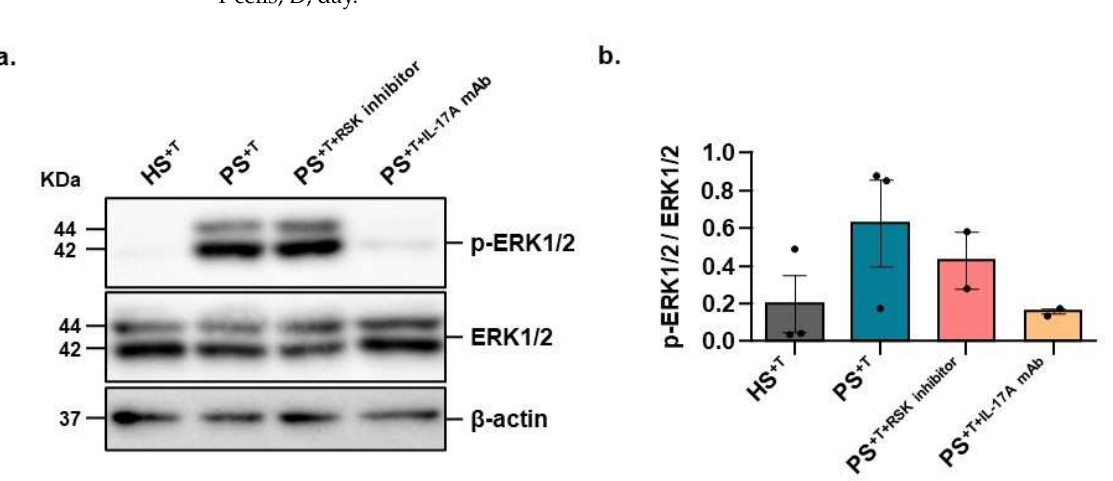
Figure 4. Contribution of ERK1/2 signaling pathway in psoriasis. ( a ) Total protein (20 µg) from the epidermal fraction of HS +T , PS +T , PS +T+RSK inhibitor and PS +T+IL-17A mAb was loaded on a 10% reducing SDS- PAGE gel. The expression of p-ERK1/2 and total ERK1/2 (ERK1/2) was monitored by Western blot analysis. β-actin is shown as a loading control. ( b ) Densitometric analysis of the immunoblots (three donors (HS +T and PS +T ) and two donors (PS +T+RSK inhibitor and PS +T+IL-17A mAb ), two skin substitutes per donor). HS +T , healthy skin substitutes with T cells; PS +T , psoriatic skin substitutes with T cells; PS +T+RSK inhibitor , psoriatic skin substitutes with T cells treated with a RSK inhibitor; PS +T+IL-17A mAb , pso- riatic skin substitutes with T cells treated with an IL-17A-neutralizing antibody. 3.5. DNA-Binding Properties of Sp1 and NF-κB in Healthy and Psoriatic Keratinocytes Stimulated by T Cells Transcription factors mediate many cellular processes by initiating and regulating gene transcription. They can act as both activators and/or repressors of transcription. In order to investigate in more detail the differences in ERK1/2 phosphorylation between healthy and psoriatic conditions, we evaluated the DNA-binding properties of two tran- scription factors that are downstream nuclear targets of ERK1/2, namely, Sp1 and NF-κB, in nuclear extracts prepared from monolayers of either healthy or psoriatic keratinocytes stimulated with T cells. EMSA analyses clearly demonstrated that the DNA-binding prop- erties of these two transcription factors are strongly increased in psoriatic keratinocytes compared with healthy ones (Figure 5a,b). The specificity of the complex formation was validated by competition experiments. Indeed, the formation of both the Sp1 and NF-kB complexes was prevented only by unlabeled competitor oligonucleotides bearing their respective high-affinity DNA binding sites (Figure 5c,d). Moreover, the addition of anti- bodies directed against either Sp1 or NF-κB significantly reduced the formation of these complexes in EMSA and also produced new, slow-migrating supershifted complexes (SCC), confirming once again the presence of both Sp1 and NF-κB in these DNA–protein complexes (compare lanes 7 and 8 with lane 2 (negative control) for Sp1 and Sp1/Sp3 in Figure 5c and lane 7 with lane 2 (negative control) for NF-κB on Figure 5d). We then eval- uated the expression of both Sp1 and NF-κB by Western blot and gene profiling analyses to establish whether the increased DNA binding observed for these transcription factors in the EMSA resulted from a corresponding increase at the protein level or from an